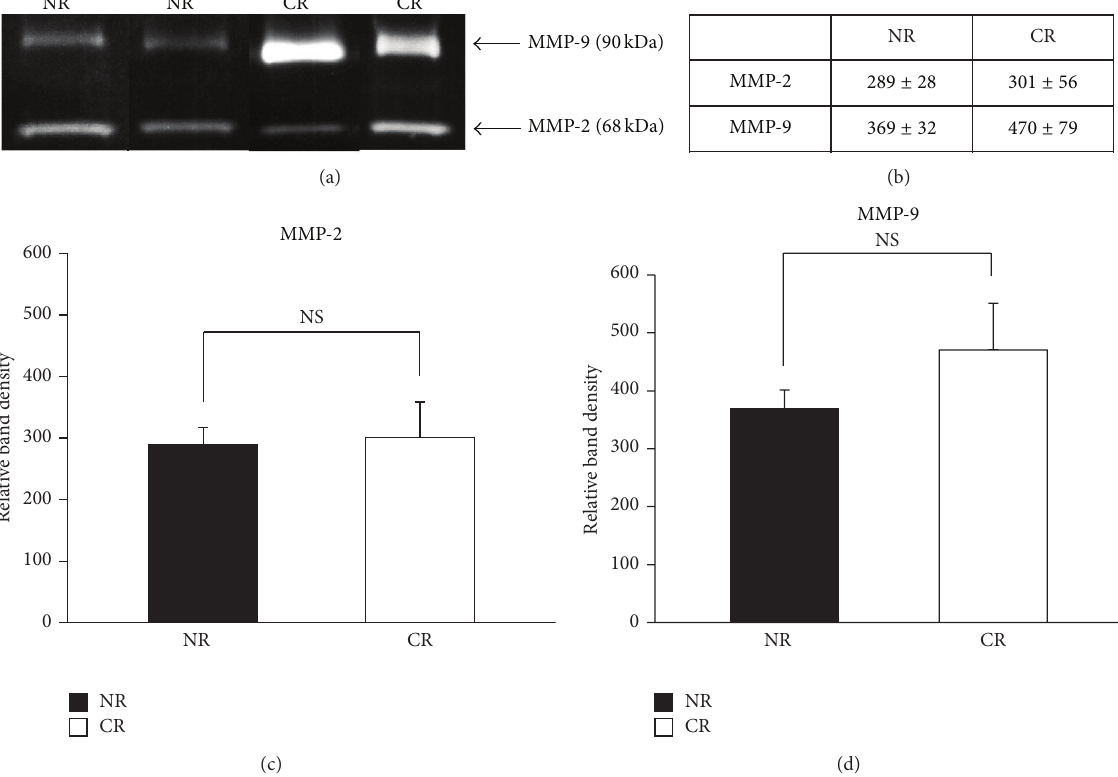
Figure 3: Gelatin zymography of human plasma from kidney transplant patients. Bradford protein assay was used to quantify the amount of plasma needed for zymography that was then loaded onto gelatin gels. The gels were scanned and analyzed using imageJ. (a) Representative gels are of MMP-2 and MMP-9 from patients with no rejection (NR) and patients with chronic rejection (CR). (b) Mean relative band density of MMP-2 and MMP-9 in NR ( 𝑛 = 50) and CR ( 𝑛 = 17) patients was measured by densitometry. Statistics are shown as mean ± SEM. (c, d) Graphical representation of Figure 3(b). The 𝑃 value was calculated using Student’s 𝑡 -test. NS: not significant.